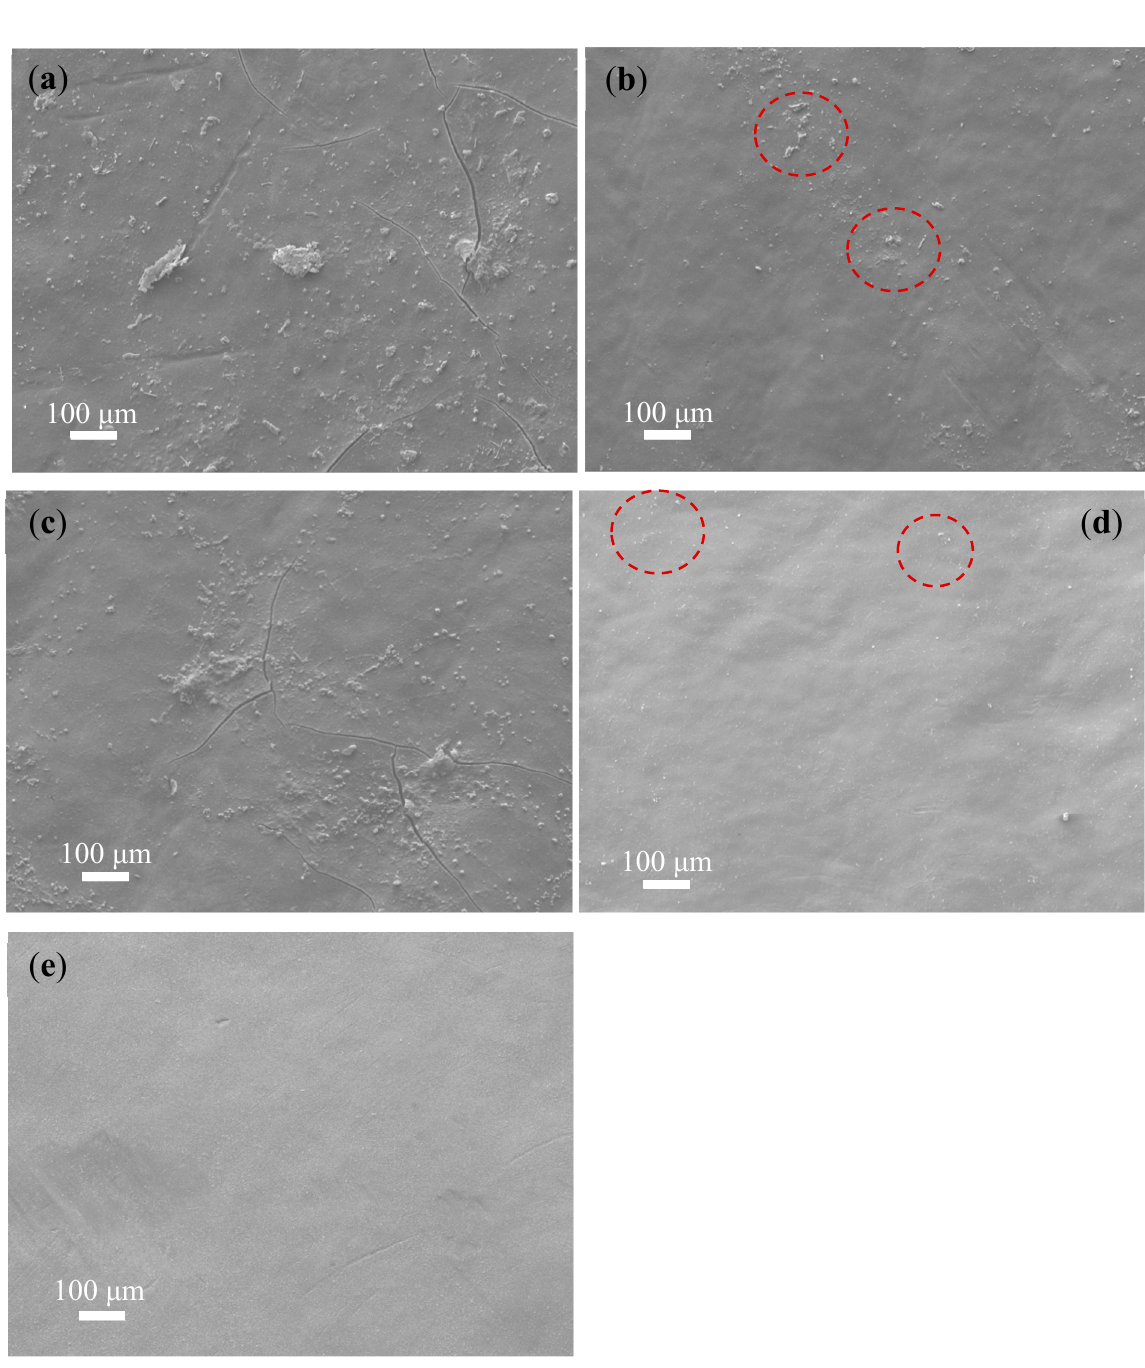
Figure 5. SEM images of fouled and cleaned membranes of ( a ) P1, ( b ) P1-clean, ( c ) P2, ( d ) P2-clean, and ( e ) virgin membrane.